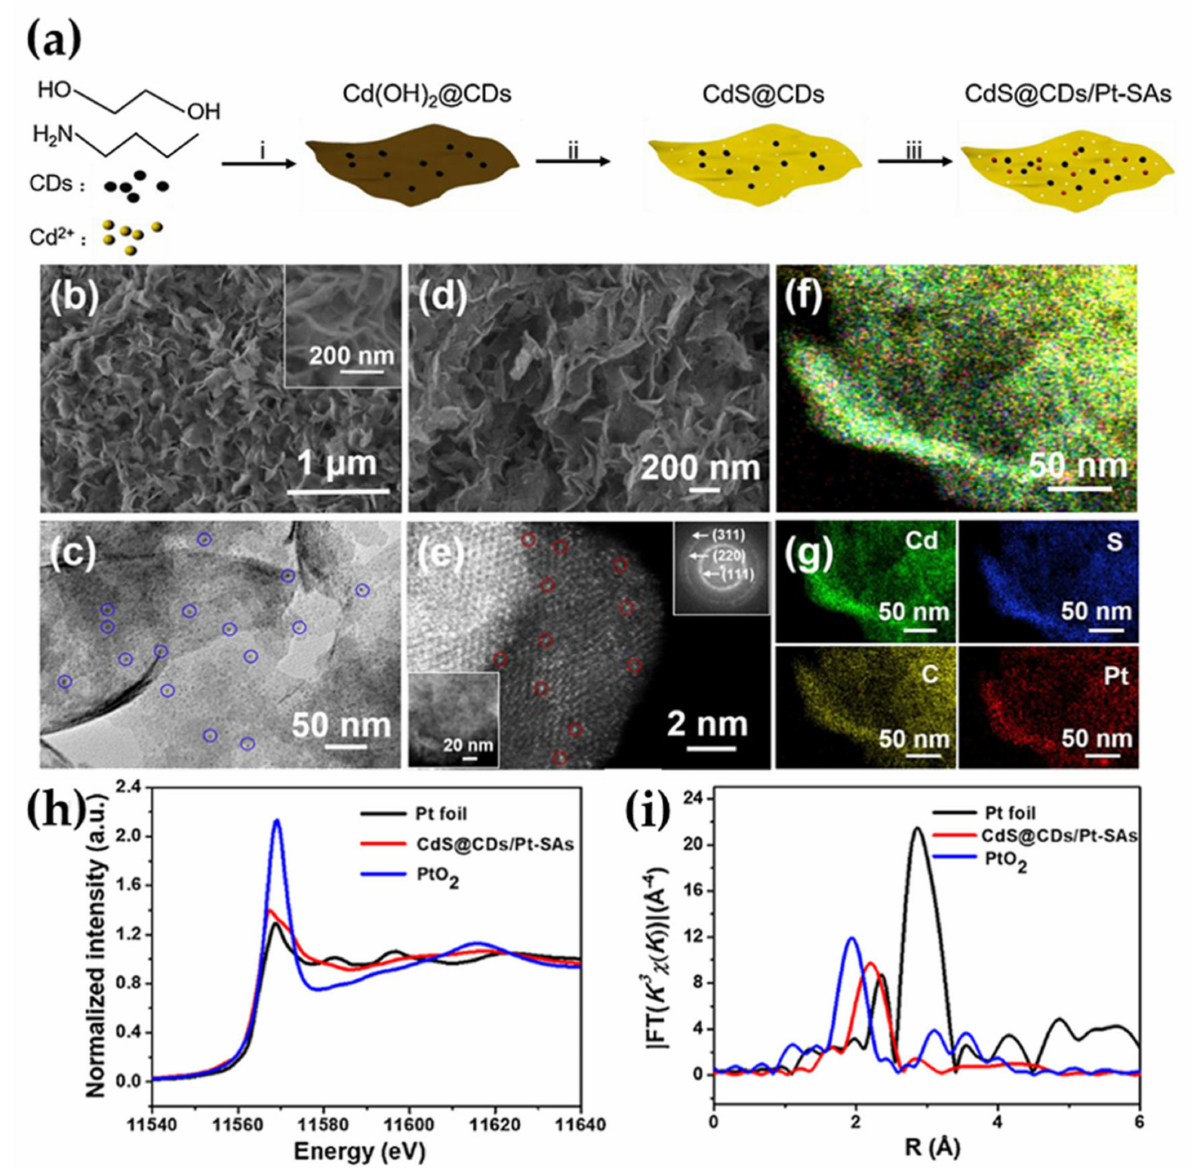
Figure 7. ( a ) Schematic illustration for the synthesis of CdS@CDs/Pt-SAs: (i) Cd(OH) 2 @CDs was synthesized by the reaction of cadmium acetate with n-butylamine in a mixture of ethylene glycol and CDs aqueous solution via solvothermal method, (ii) Reaction of sulfidation process to produce CdS@CDs, (iii) Pt single-atoms were loaded by in-situ impregnation and conversion; ( b ) SEM image and ( c ) HRTEM image for Cd(OH) 2 @CDs; ( d ) SEM image and ( e ) HAADF-STEM image of CdS@CDs/Pt-SAs. The insets show the HRTEM image (bottom-left), SAED pattern (up-right), and ( f , g ) EDS elemental mapping of CdS@CDs/Pt-SAs; ( h ) The normalized Pt-edge XANES spectra of different samples and reference; ( i ) Fourier transform magnitudes of the experimental Pt L3-edge EXAFS spectra of Pt foil, PtO 2 , and CdS@CDs/Pt-SAs